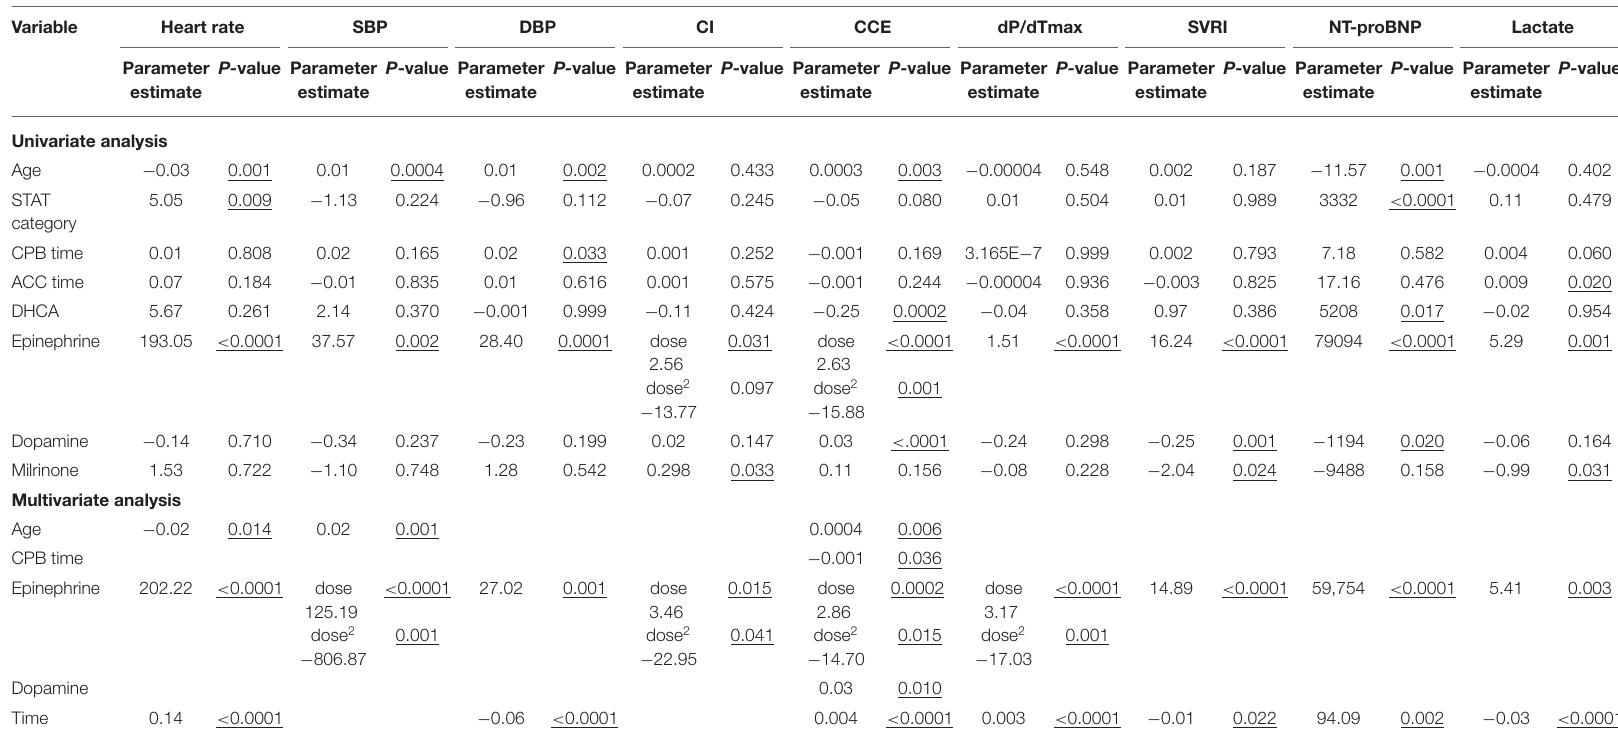
P-values < 0.05 were underlined. ACC, aortic crossclamp time; CCE, cardiac cycle efficiency; CI, cardiac index; CPB, cardiopulmonary bypass; DBP, diastolic blood pressure; DHCA, deep hypothermic circulatory arrest; dP/dT max , the maximal slope of systolic upstroke; SBP, systolic blood pressure; SVRI, systematic vascular resistance